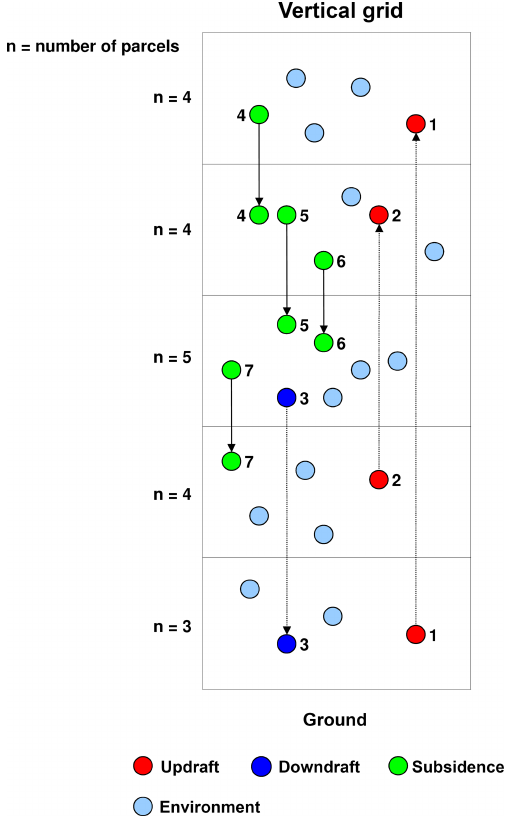
Figure 1. Mode of operation of Lagrangian convection in a vertical column. Coloured circles are Lagrangian parcels; n = 3, 4, and 5 is the original number of parcels in a grid box (chosen arbitrarily for this example) that should be reached again after the convective event to keep the air mass in each grid box